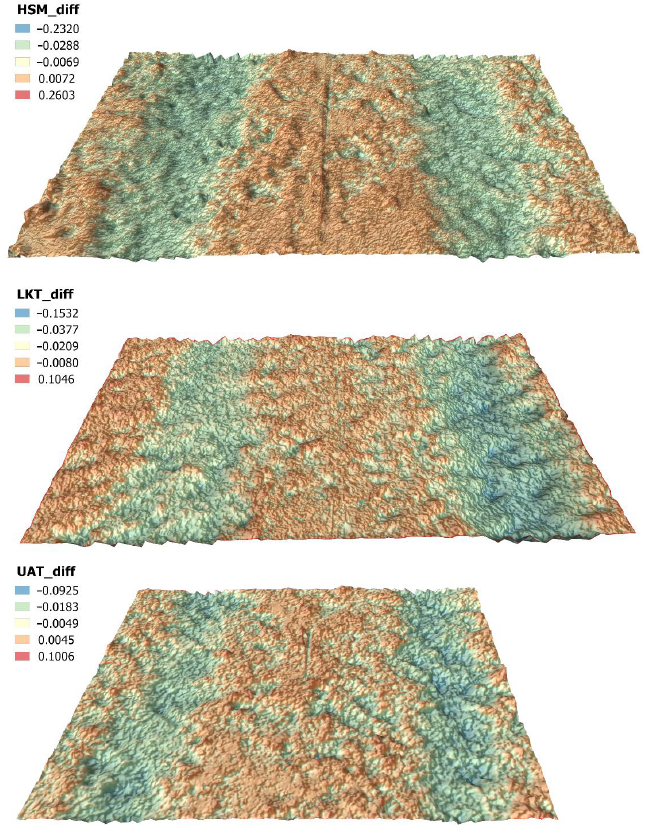
Figure 7. The rasters calculated as differences between the 40th pass surface and surface before passes (m) for individual plots.